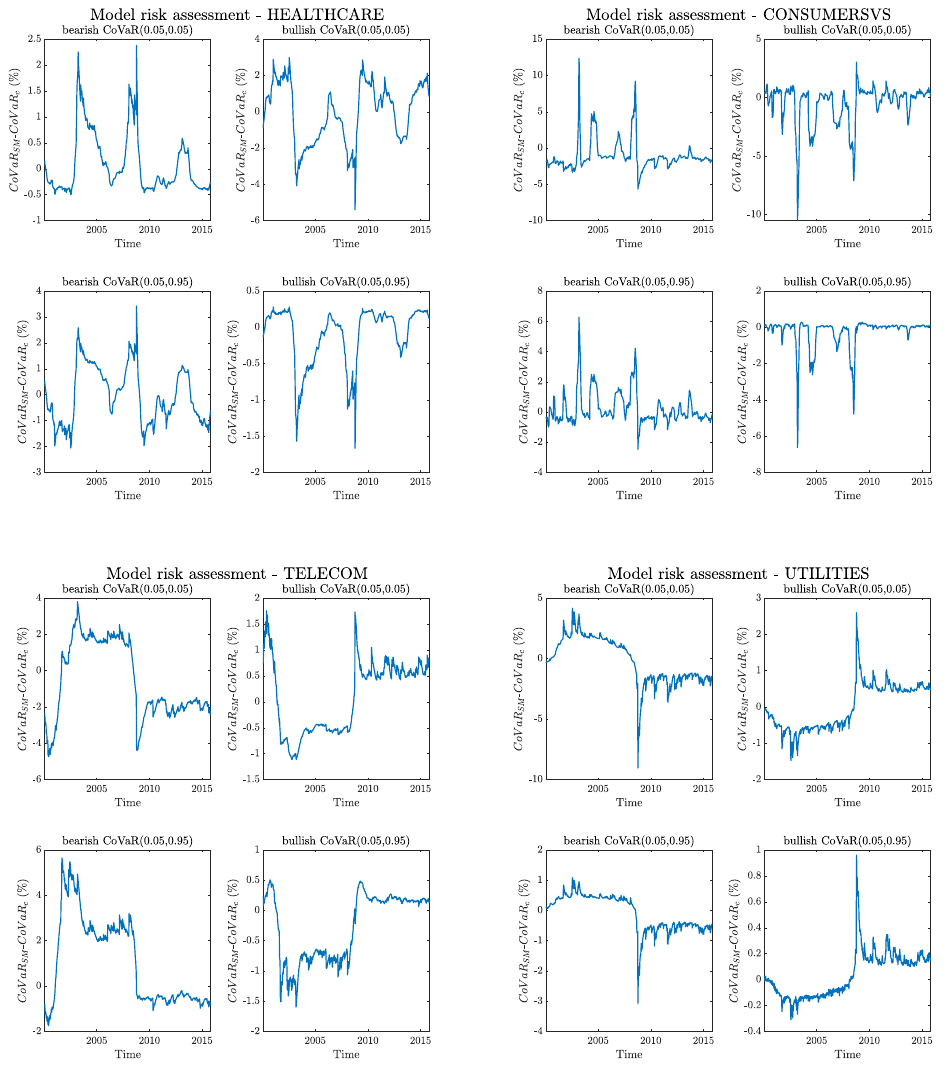
These figures show the difference between the estimation of the same percentile of stock sector returns under the same oil-related scenario using the Switching Markov model that allows for changes in the copula against the constant model. Top figures focuses on a low quantile ( β = 5%) whilst bottom graphs estimate the high quantile ( β = 95%). Left figures show a percentile of stock returns under a bearish scenario for oil returns, i.e. oil returns below its percentile 5%, and right figures show a percentile of stock returns under a bullish scenario for oil returns, i.e. oil returns above its percentile 95%. These charts indicate the higher model risk in the lower tail than in the upper tail when assuming a constant dependence across